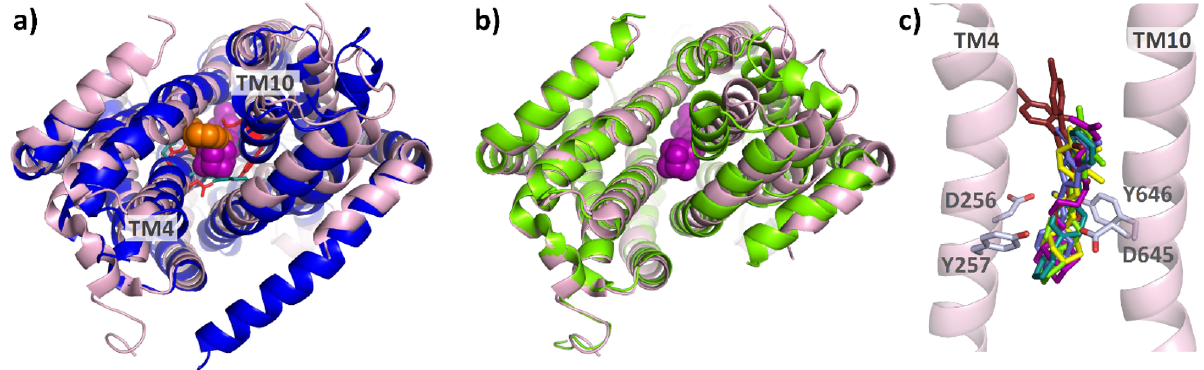
Figure 16. Comparison of AcrB/BDM88855 and inhibitor-bound co-structures of MmpL3: As can be seen from the bottom view ( a ) on the overlayed TMDs of AcrB/BDM88855 (7OUK) (blue/orange) and MmpL3/SQ109 (6AJG) (pink/magenta), both inhibitors bind to comparable areas within the respective proton relay networks (cyan and red sticks). A comparison of the inhibitor-bound MmpL3 co-structure and the native structure (6AJF) (green) shows that inhibition of MmpL3 is also associated with lateral shifts of the TMD repeats ( b ). The effects of MmpL3 inhibitors SQ109 (6AJG) (magenta), AU1235 (6AJH) (yellow), ICA38 (6AJJ) (light green), NITD-349 (7C2M) (light blue), SPIRO (7C2N) (teal), and rimonabant (6AJI) (brown) are likely all based on the disruption of the two Asp-Tyr pairs (D256, Y646 and D645, Y257) ( c ).